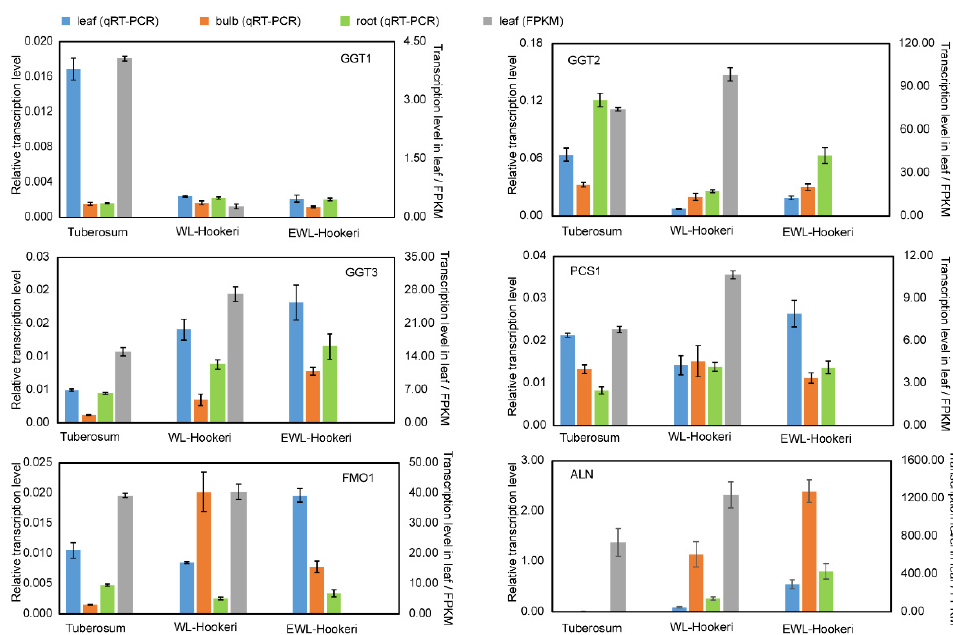
Table 4. Stability comparison of the candidate genes analyzed and ranked by BestKeeper.